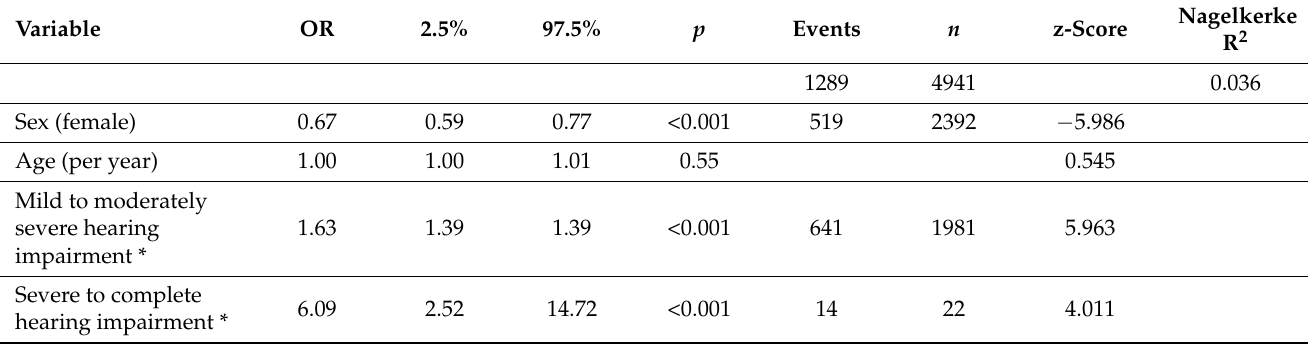
Table 3. Logistic regression of tinnitus on sex, age and hearing impairment (by WHO